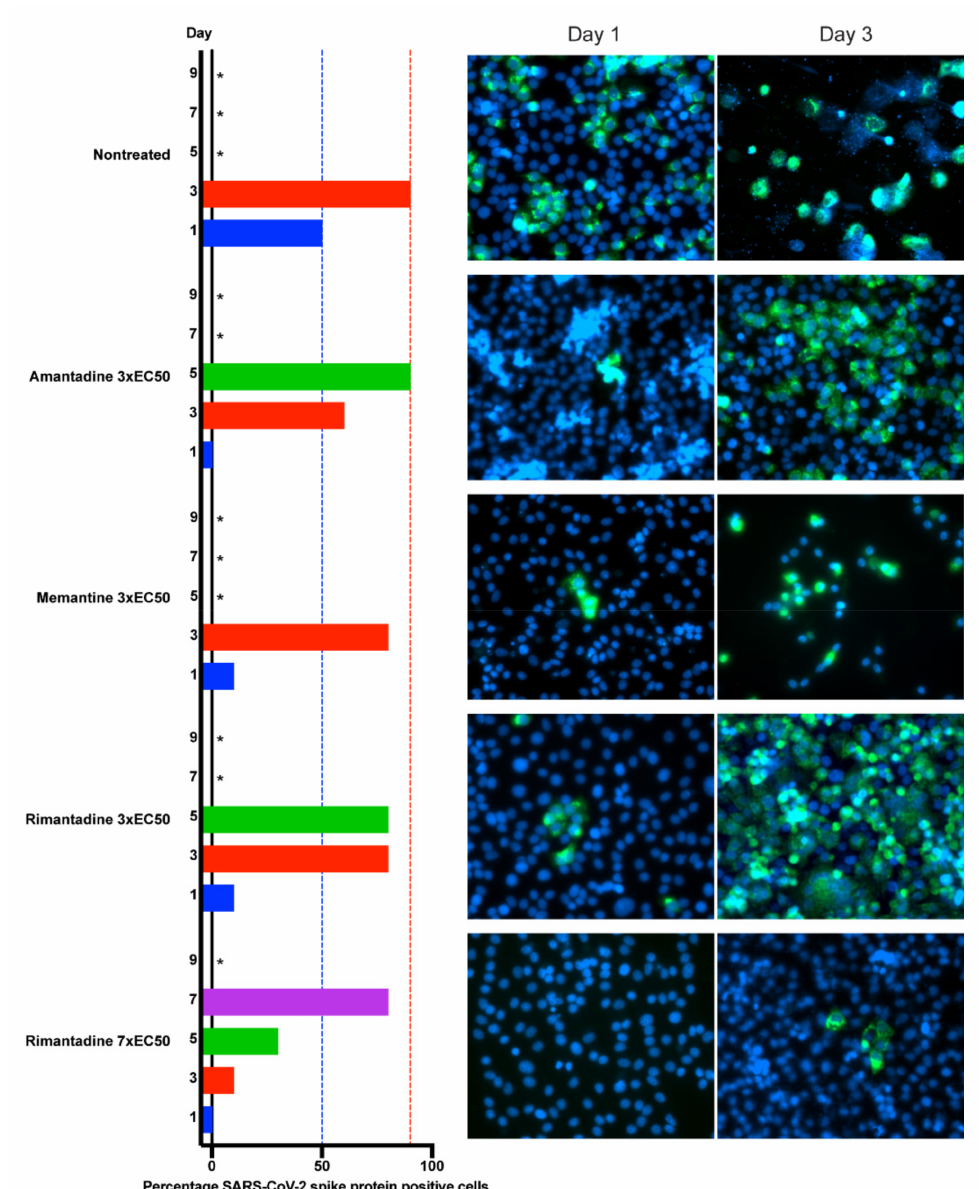
Figure 3. Comparison of barrier to SARS-CoV-2 escape of ion-channel inhibitors in VeroE6 cells. VeroE6 cells seeded in T25 cell culture flasks were infected with SARS-CoV-2 and treated with ion- channel inhibitors amantadine, memantine or rimantadine, at specified concentrations. Inhibitors were administered immediately after infection and on day 1, 3, 5 and 7 upon splitting of cells. % of SARS-CoV-2 infected cells on the specified days post infection was determined by immunostaining for SARS-CoV-2 spike protein (green) relative to counterstaining of cell nuclei with Hoechst dye (blue). Images were obtained using a Zeiss Axiovert microscope equipped with a 40 × LD Plan-Neofluar objective. Cultures summarized in this figure are derived from different experimental setups, each including an infected-nontreated control culture, which showed viral spread comparable to that in the depicted representative culture. * Culture was terminated, or infection data not recorded, due to virus induced cell